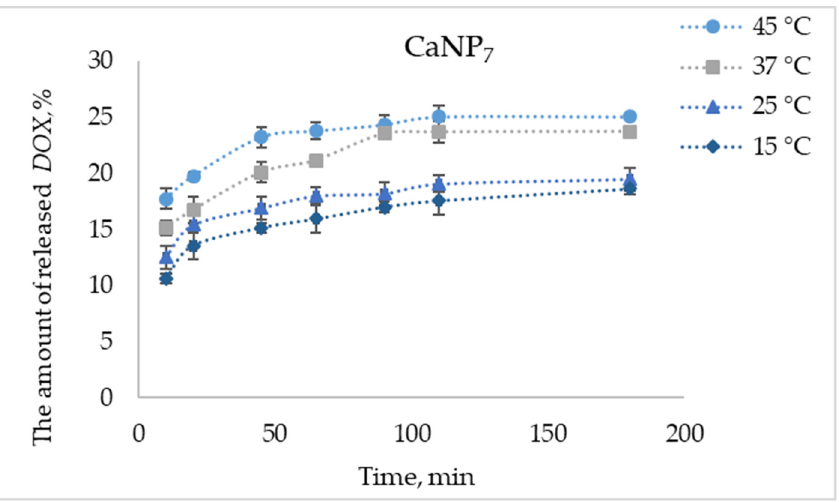
Figure 9. The proportion of released DOX (from CaNP 7 - DOX ) as a function of time at pH 6.5 and different temperatures.